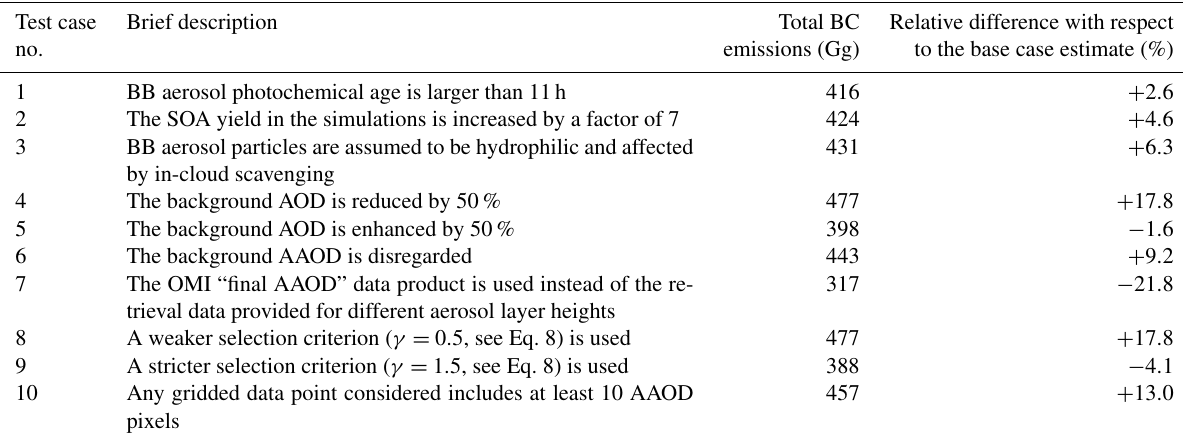
Table 4. Estimates of the total BC emissions (in Tg) from fires in the study region over the period from 1 May to 30 September 2012 for several test cases of the estimation